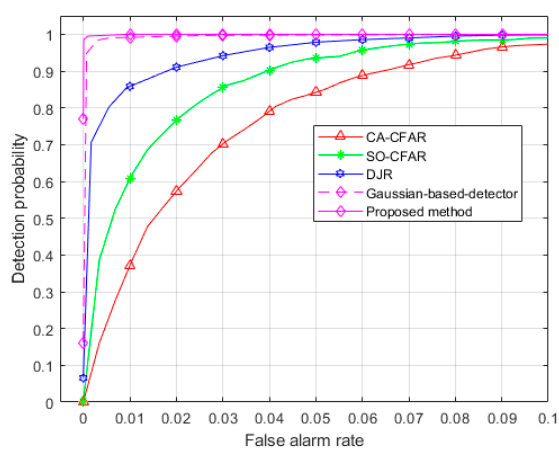
Figure 5. Receiver-operating-characteristic (ROC) curve for 𝜌 = 0.05 .